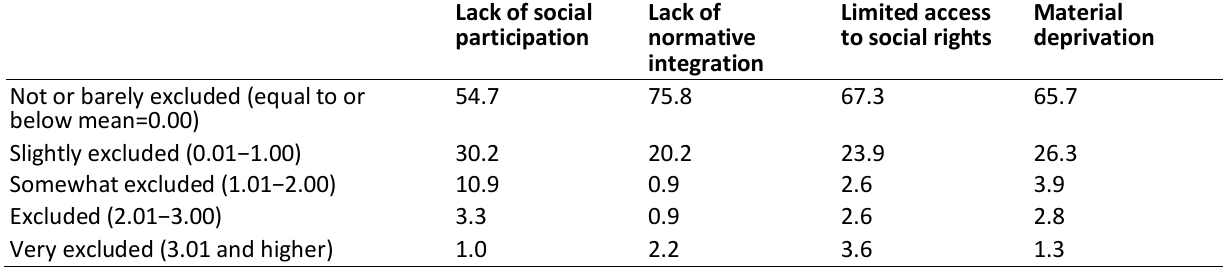
Table 4. Prevalence of four aspects of social exclusion among Dutch children, 2008 (in percentages; subscales, weighted sample).